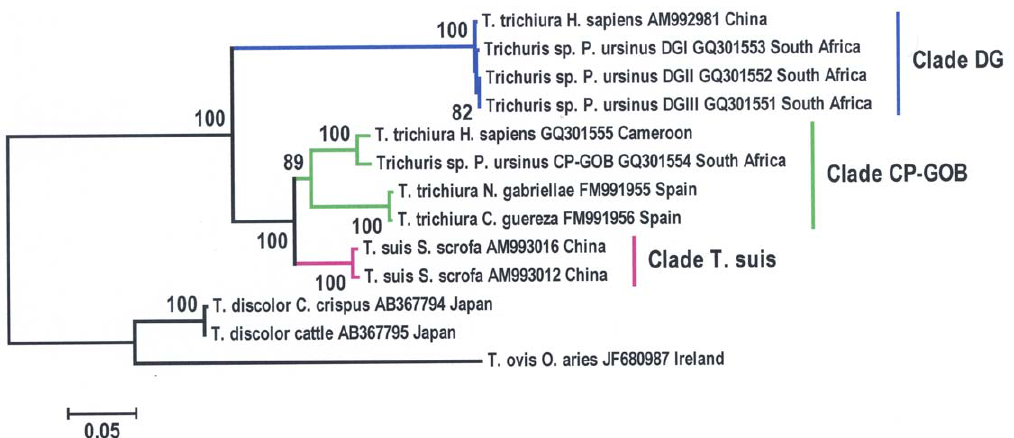
Figure 2. Neighbour-joining phylogenetic tree [ 38 ] based on a MUSCLE alignment of ITS15.8S-ITS2 sequences from Trichuris spp. isolated from human, non-human primates and pigs. Bootstrap values are indicated as percentages on the branches of the consensus tree which was inferred from 1000 replicates [33]. The tree was rooted with T. ovis and T. discolor . The evolutionary distances were computed using the Tajima-Nei method [32] and the scale represents the number of base substitutions per site. Branches corresponding to Clade DG are highlighted in blue, while branches corresponding to the Clades CP-GOB and T. suis are highlighted in green and pink, respectively.